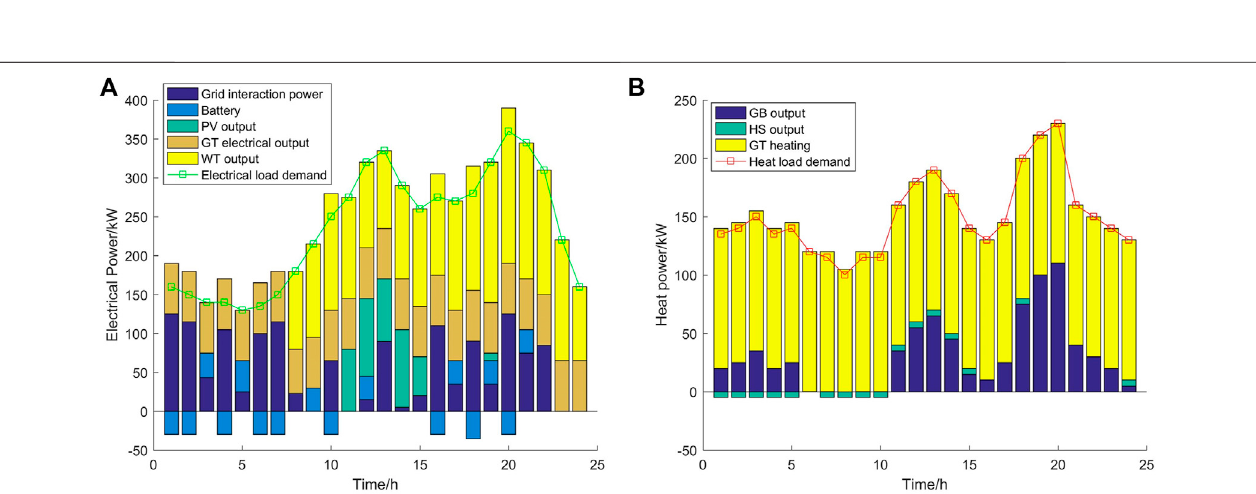
FIGURE 6 | Scenario 1: Balance of electrical load and heat load after optimization. (A) Electrical load and (B) heat load.